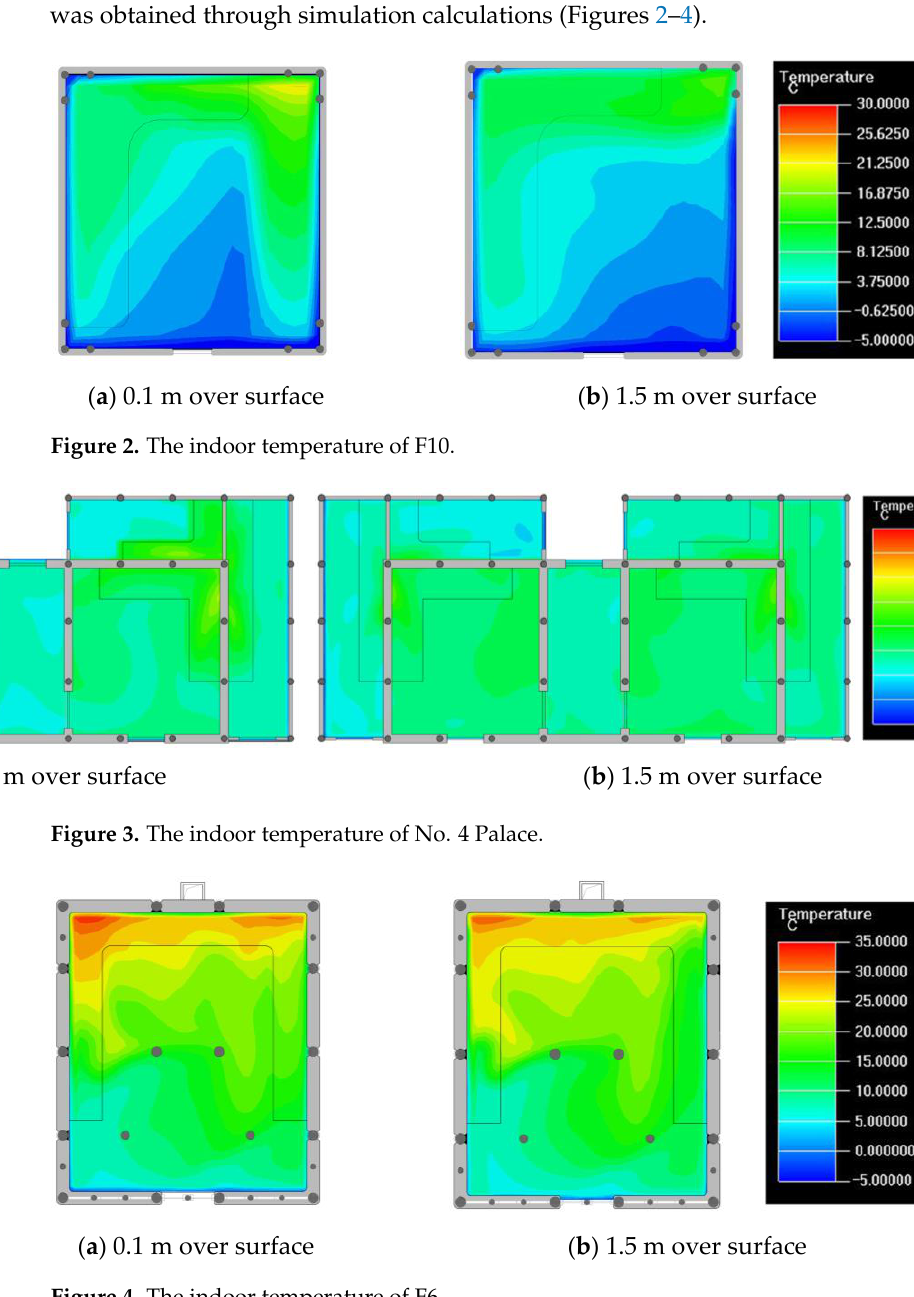
Figure 4. The indoor temperature of F6.